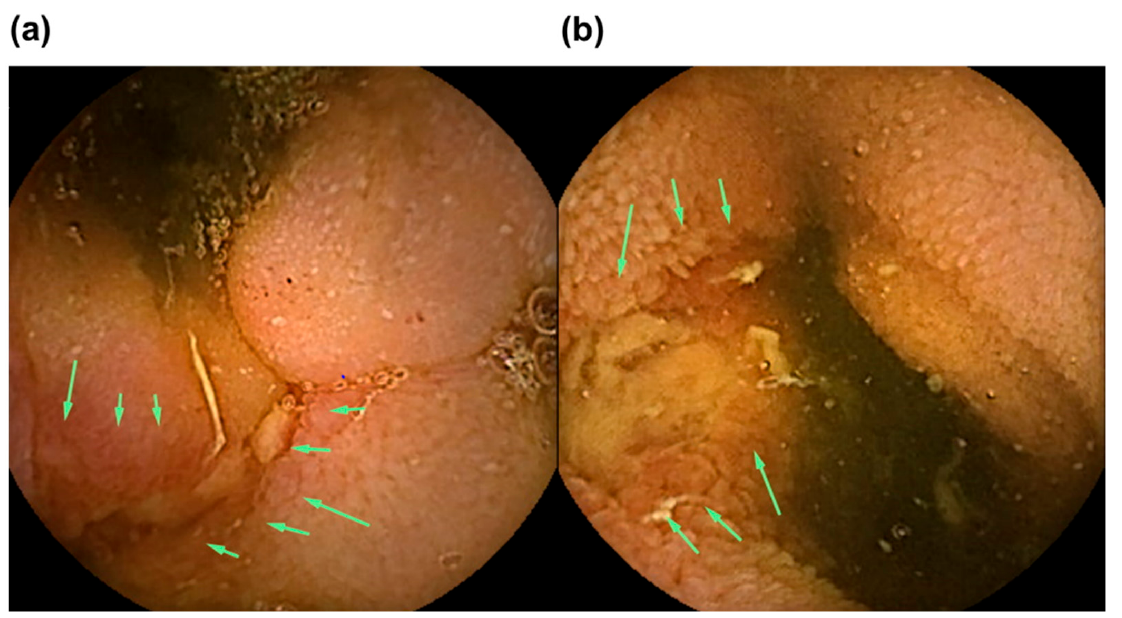
Figure 6. The original pictures of CE findings. ( a , b ) Distal ileum: linear ulcers (green arrows).